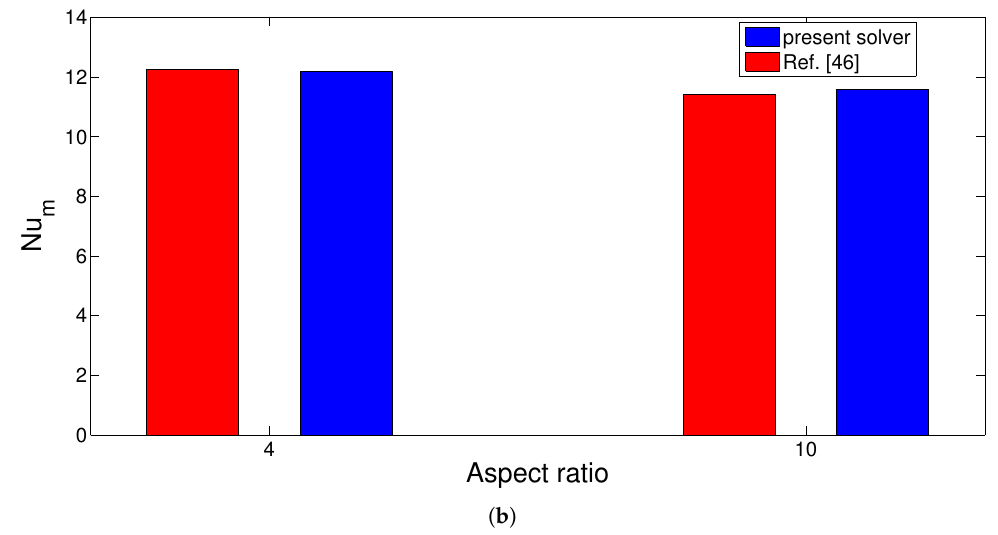
Figure 3. Comparison of local Nu number for various locations along the hot surface at Reynolds number of 100 with Ref. [45] ( a ) and average Nu number comparison for slot jet impingement cooling considering two values of aspect ratio at Reynolds number of 500 with Ref. [46] ( b ).